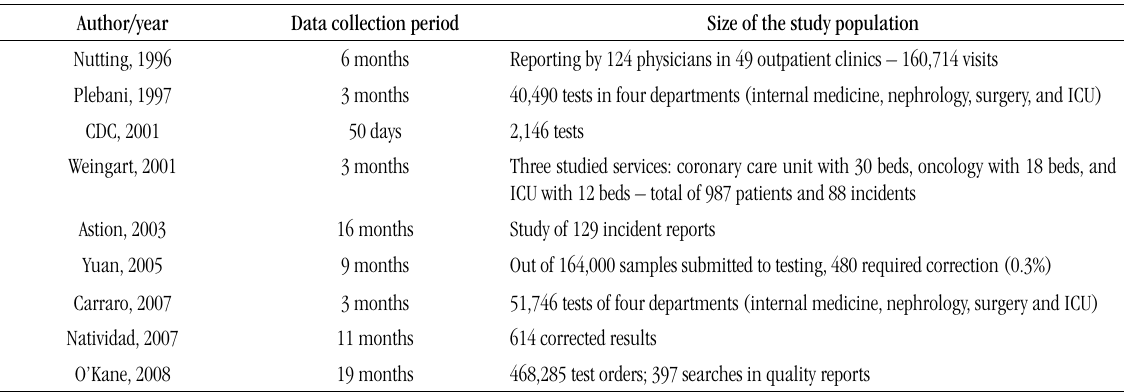
tABLE 3 – Description of data collection period, type and size of the study population, by author and publication